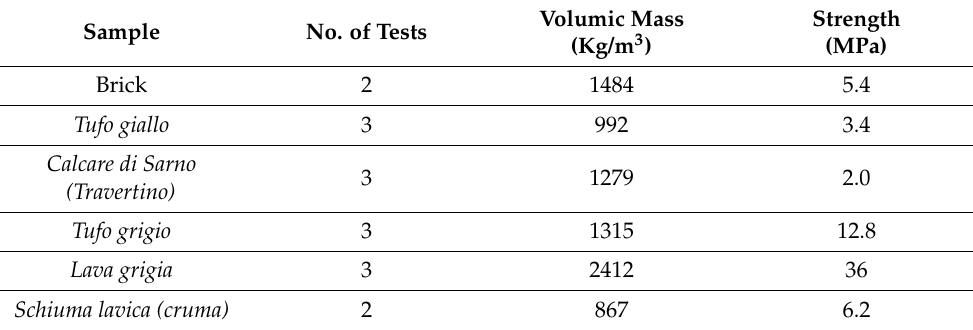
Table 2. Compression test on the masonry